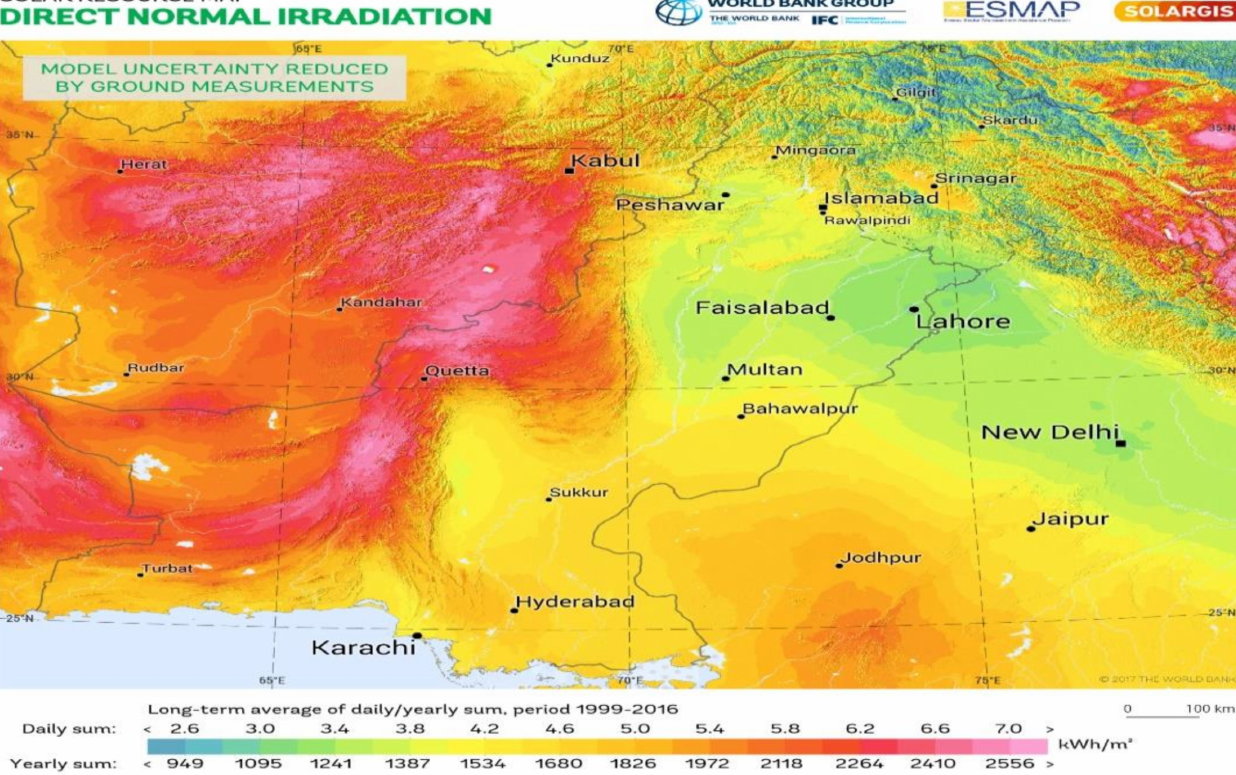
Figure 2. Solar DNI map of Pakistan